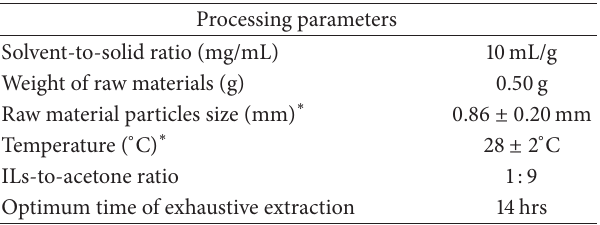
Table 1: Processing parameters used in the rotenone extraction